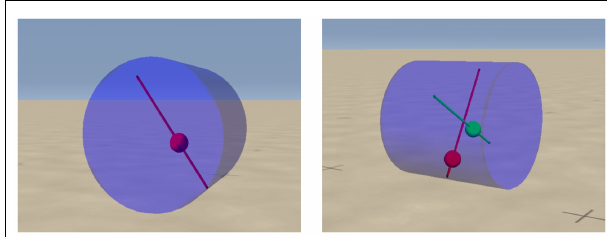
FIGURE 1 | Screenshots from the LPZRobots simulation package, of the one and two rod barrel robots used (left and right panel, respectively) .